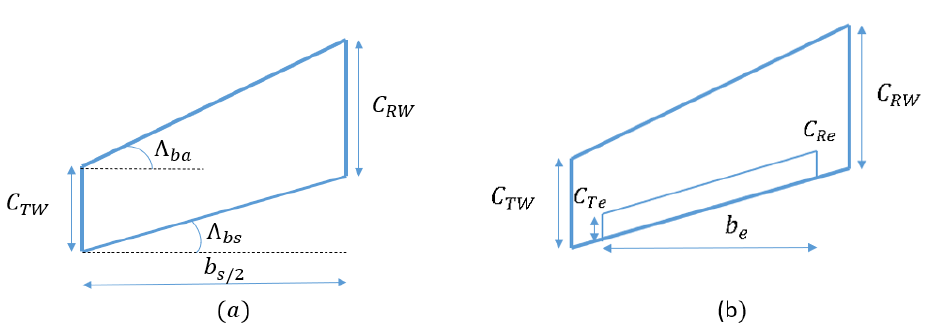
Figure 2. Wing schemes: ( a ) Elementary scheme, ( b ) Detailled scheme. Once the dimensions of the wing are known, the mean aerodynamic chord can be de- termined. The mean chord is a parameter of great importance in the study of aerodynamic properties and in the placement and distribution of loads when carrying out weight and balance tasks. The mean aerodynamic chord can be calculated using Equation (5)